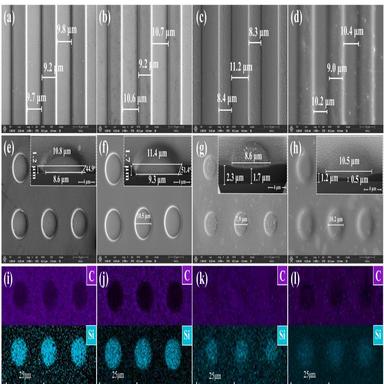
(a)-(d) The line pattern of PSPI-1, PSPI-2, PSPI-3 and PSPI-4, (e)-(h) The hole and hole's cross-sectional pattern of PSPI-1, PSPI-2, PSPI-3, and PSPI-4, (i)-(l) EDS spectrum of the C and Si elements.